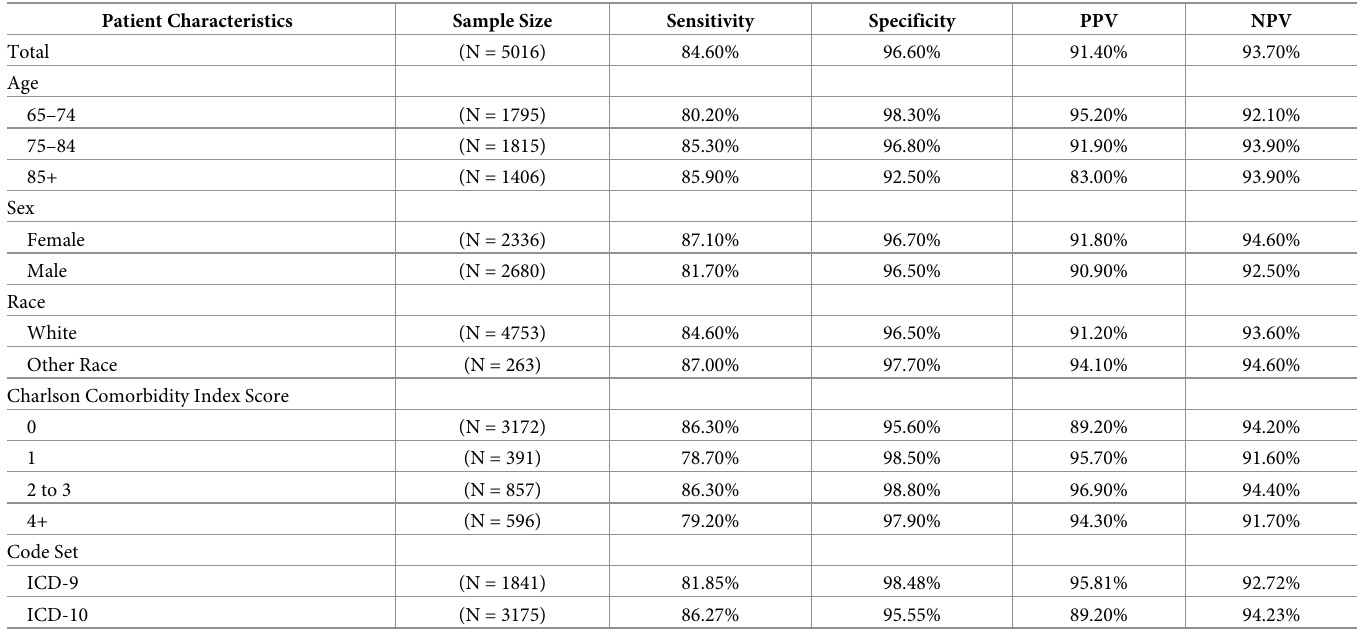
Table 3. Summary of diagnostic characteristics of iDNR relative to eDNR, stratified by patient characteristics.